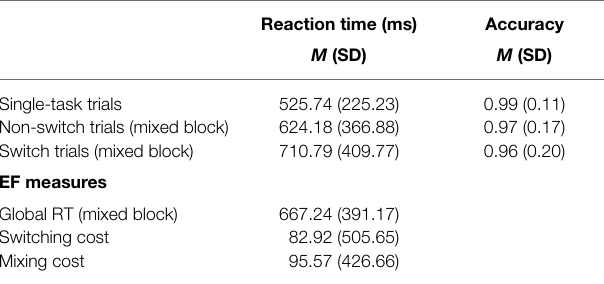
TABLE 4 | Mean RTs (ms) and accuracy, and EF measures derived from the